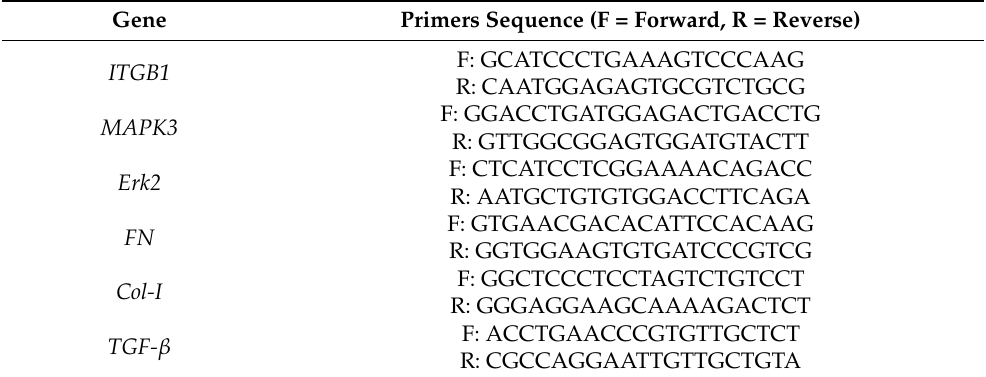
Table 2. Primer pairs for